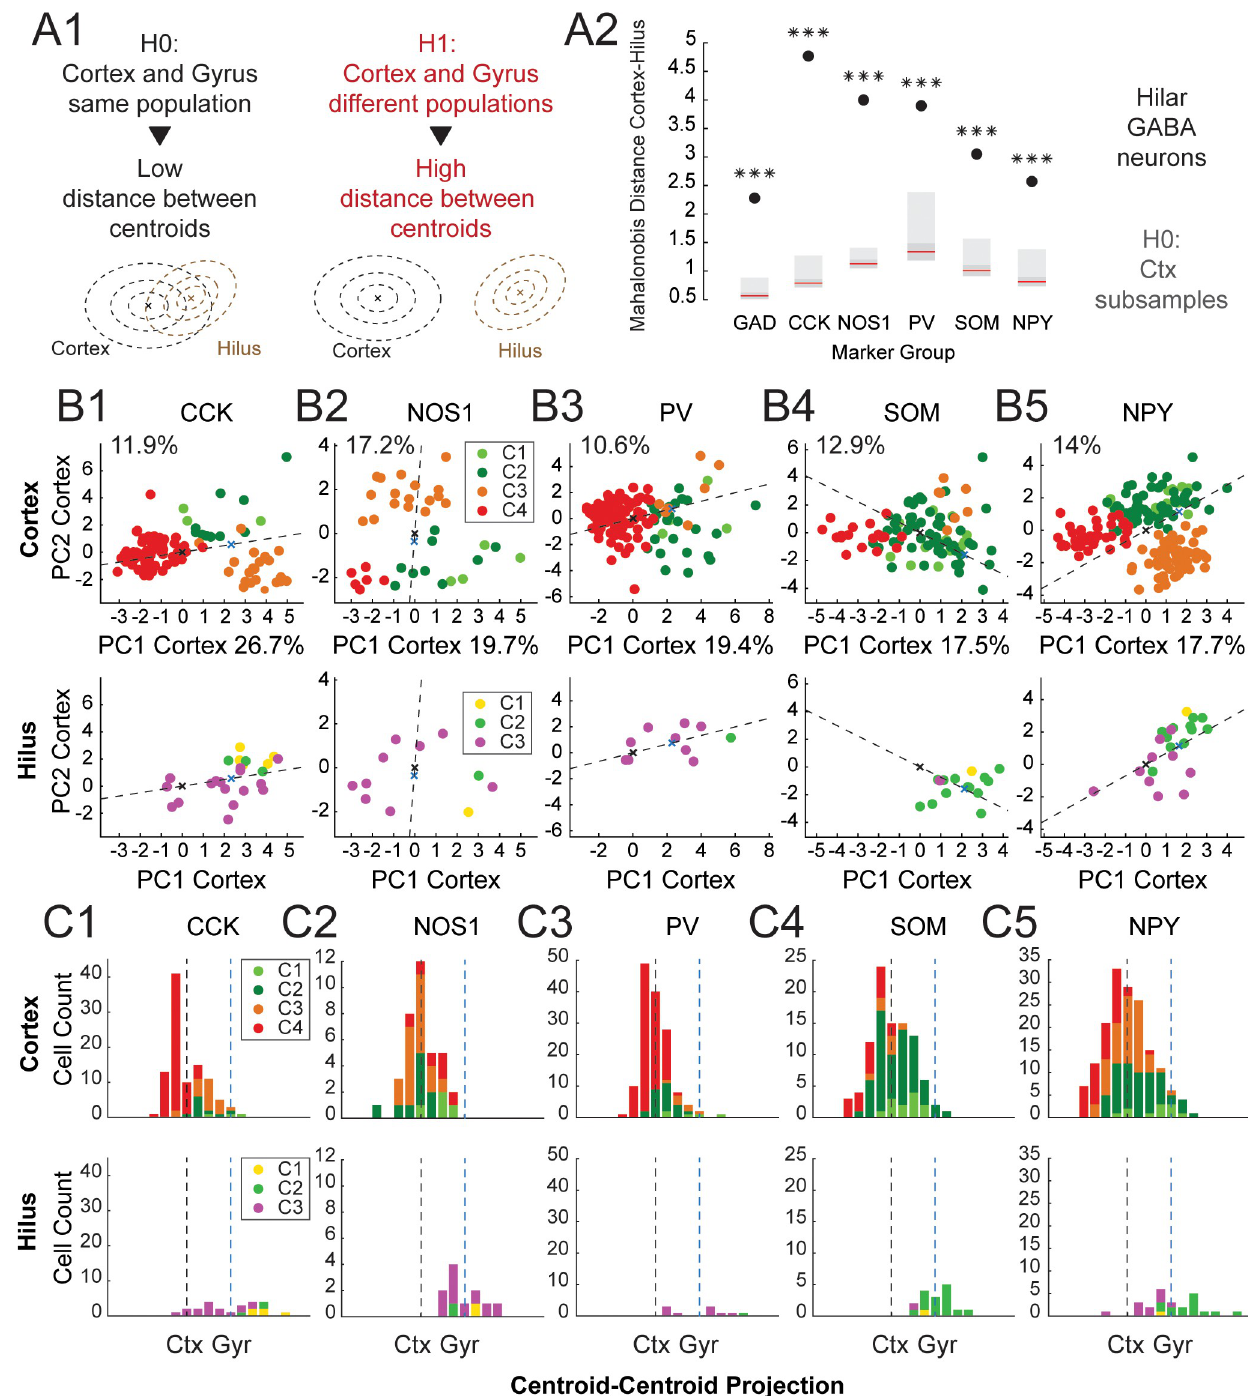
Fig 5. Forebrain interneuron markers label distinct population in the cortex and dentate gyrus. A: GAD, CCK, NOS1, PV, SOM and NPY expression defines populations having distinct centroids in the cortex and in the dentate gyrus. 1: Sketch illustrating the H0 and H1 hypotheses in a test of distance between the centroids of 2 groups of neurons. Under H0, hilar and cortical GABAergic neurons come from the same population and their centroids are close. Under H1, hilar and cortical GABAergic neurons come from different populations and their centroids are further apart. The distribution of the centroid distance under H0 was estimated by subsampling as many cortical neurons as there were hilar neurons for each marker. Resampling was performed 1000 times. 2: Actual value of Centroid-Centroid Mahalanobis distances between cortical and hilar GABAergic neurons for each marker overlaid on H0 distributions (light grey: 2.5–25% and 75–97.5% percentiles; dark grey: 25–75% percentiles; red line: median). Mahalanobis distances were